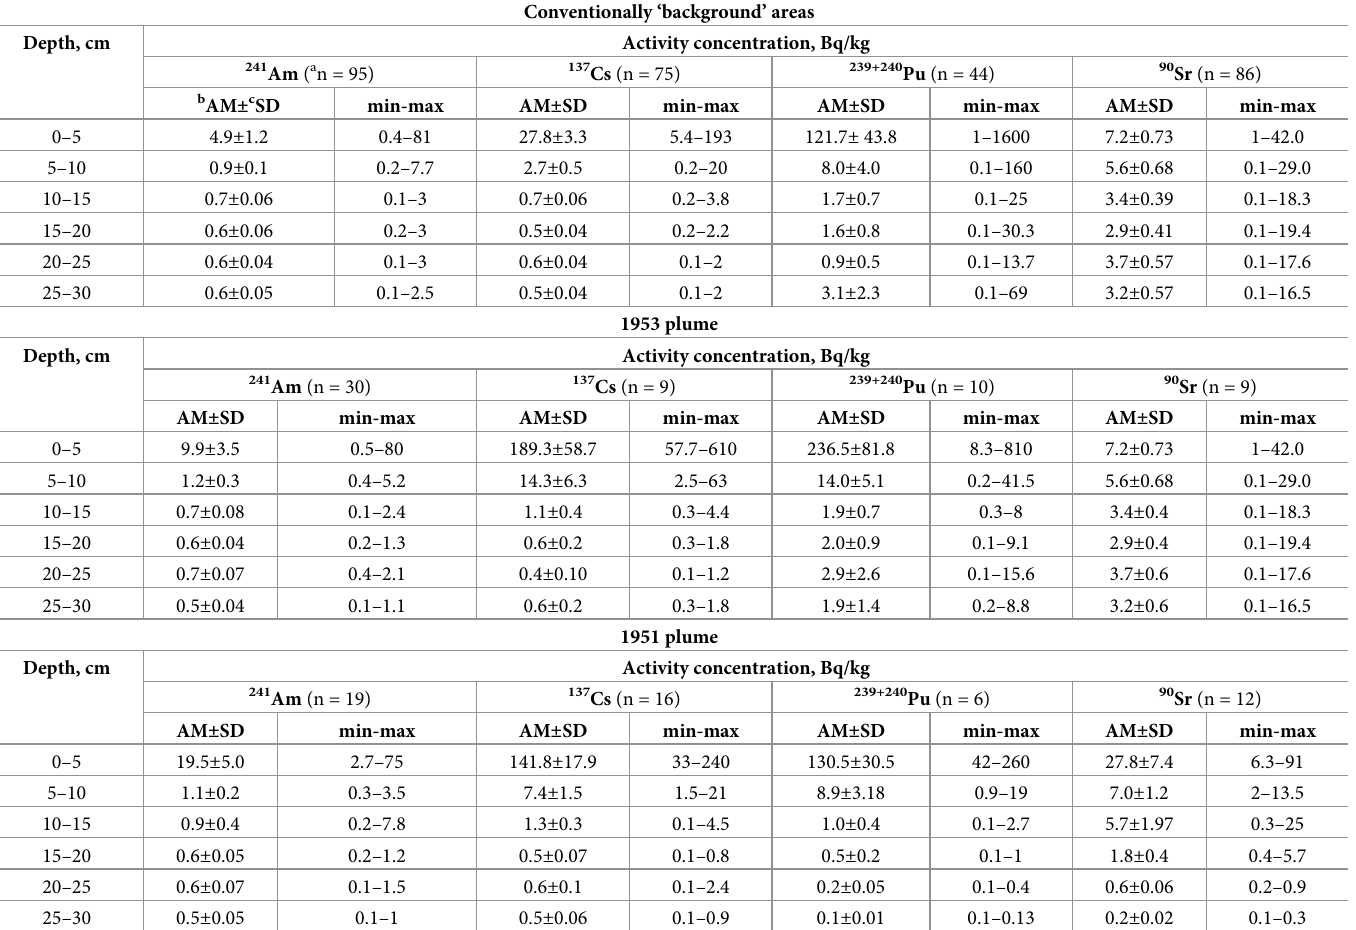
Table 1. Activity concentrations of radionuclides in soil layers down to 30 cm